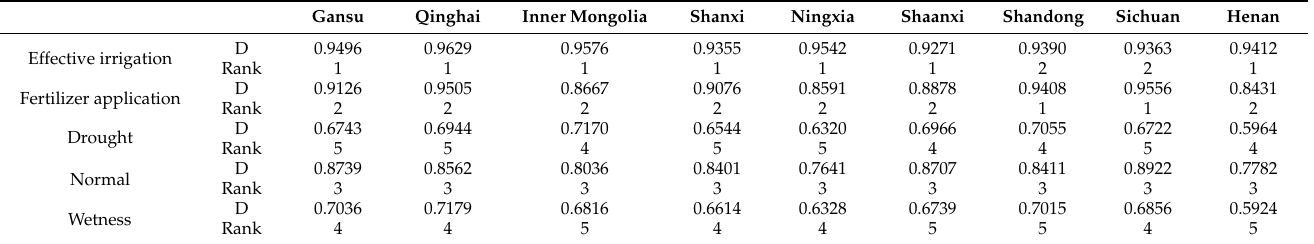
Table 4. Grey correlation degree between grain yield per unit area and related influencing factors in Yellow River basin from 1979 to